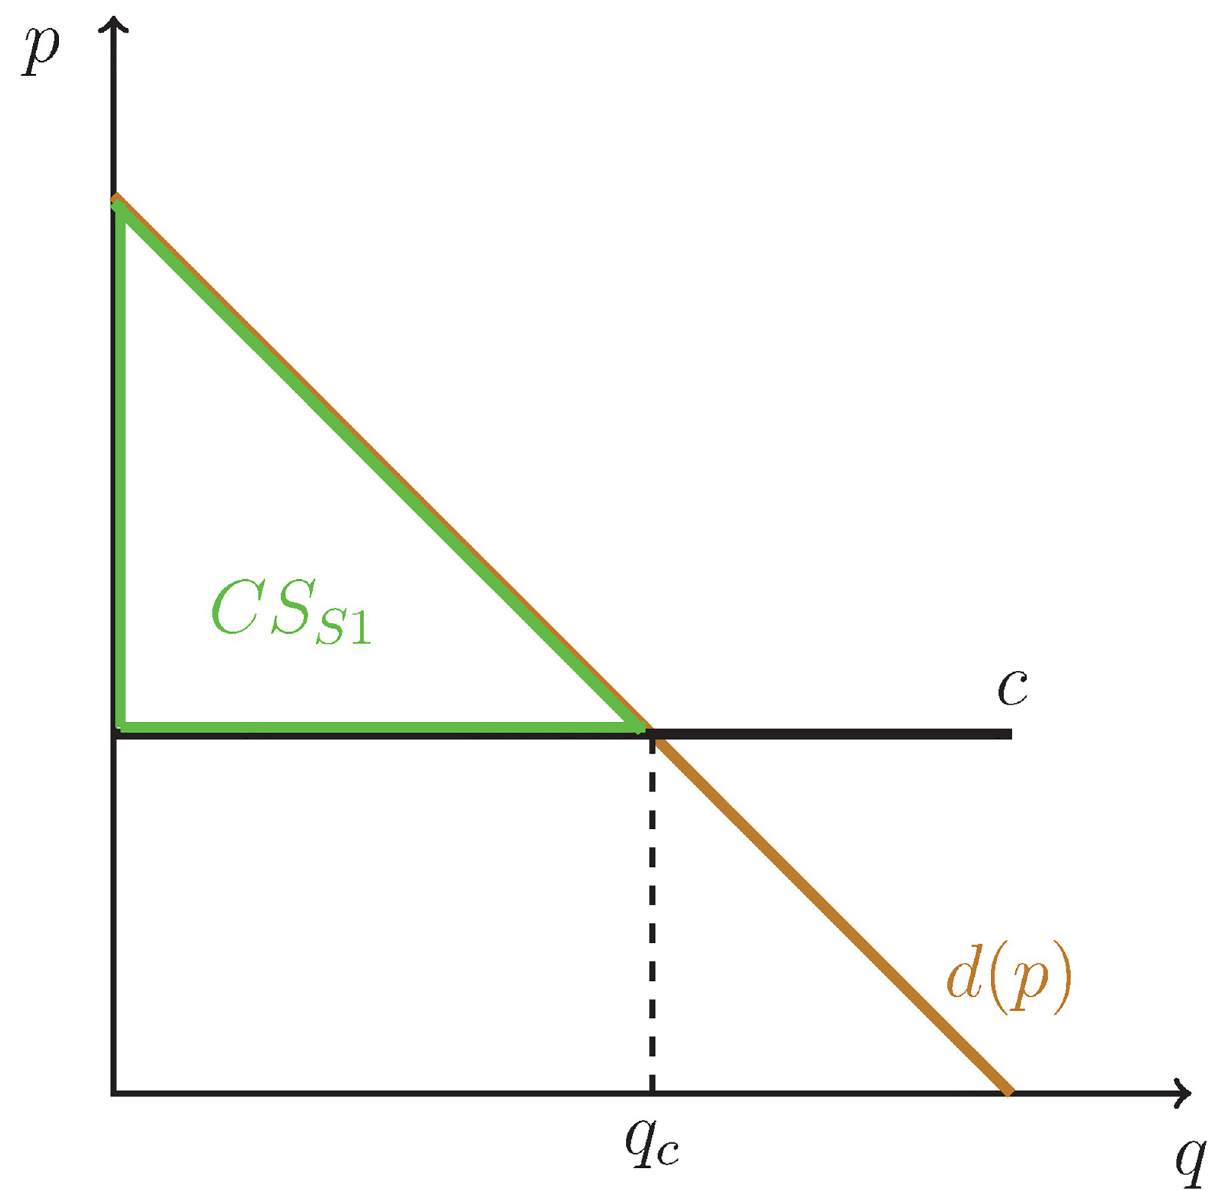
Fig 3. Case 2, market 1: Perfect competition with constant marginal